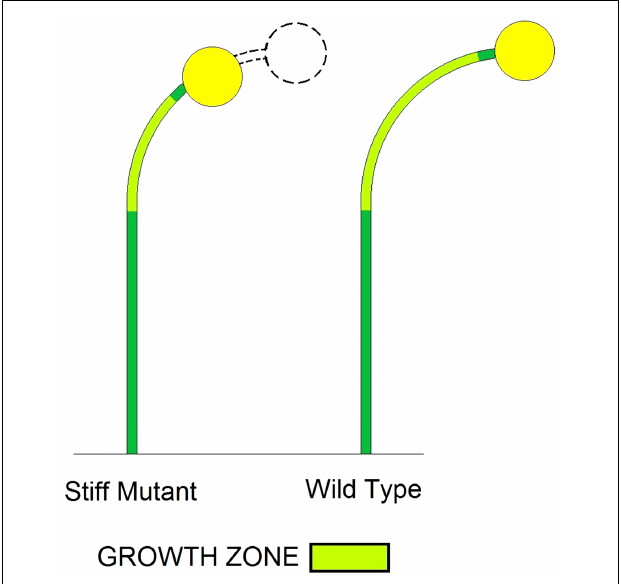
angle and bend rate compared to a wild type stage IVb sporangiophore. The stiff mutant stage IVb sporangiophore has a shorter growth zone (light green) compared to the wild type stage IVb sporangiophore. It is assumed that both sporangiophores bend at the same rate, i.e., both growth zones have the same curvature. It can be seen that the longer growth zone of the wild type produces a larger bend angle compared to the stiff mutant with a shorter growth zone. So if the sporangiophore is capable of producing a constant bend rate per unit length of growth zone (same curvature), then it follows that a longer growth zone will produce a larger bend rate compared to a shorter growth zone.This can explain how the shorter growth zones of the stiff mutant stage IVb sporangiophores produce a smaller bend rate compared to wild